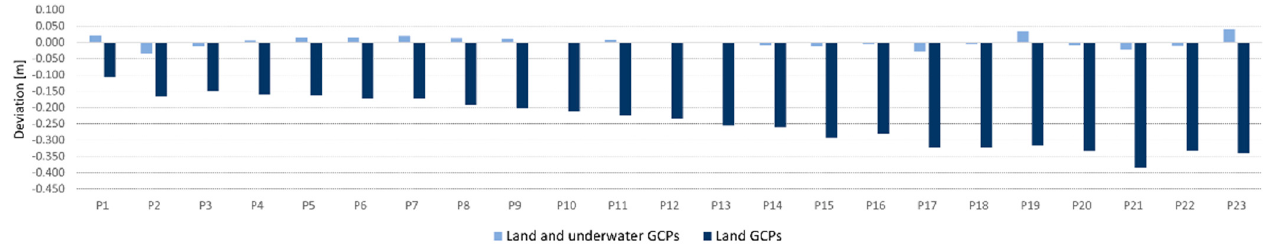
Figure 6. Height differences at the check points obtained from DTMs for land and underwater GCPs (light blue) and land GCPs (dark blue). P1–P23 means the points along the profile.